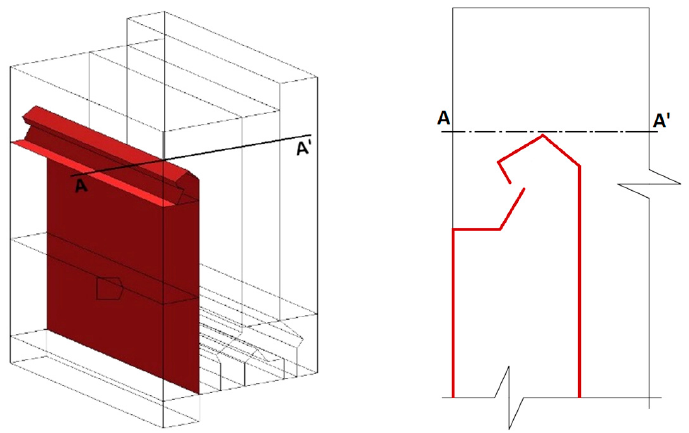
Figure 10. The cross-section by a line A-A’.